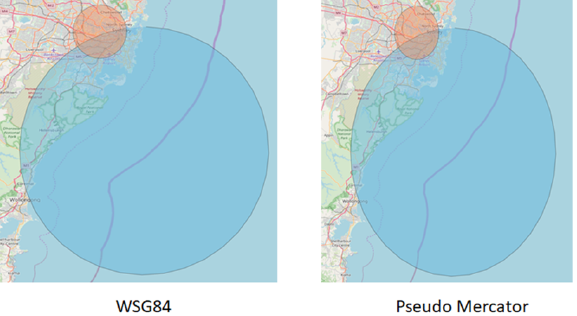
Figure 9. Differences between WGS84 and Pseudo Mercator. Figure 10. Tsunami Message decoded and displayed during Fire Message timeslot